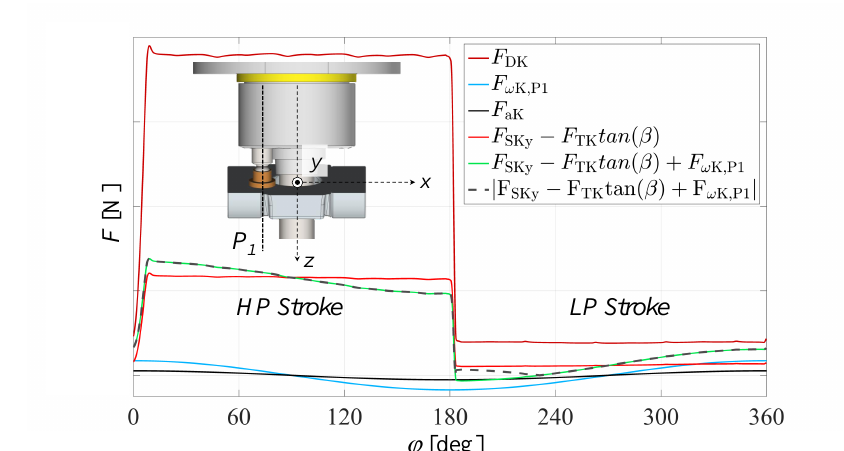
Figure 3. Forces acting on the piston in plane P 1